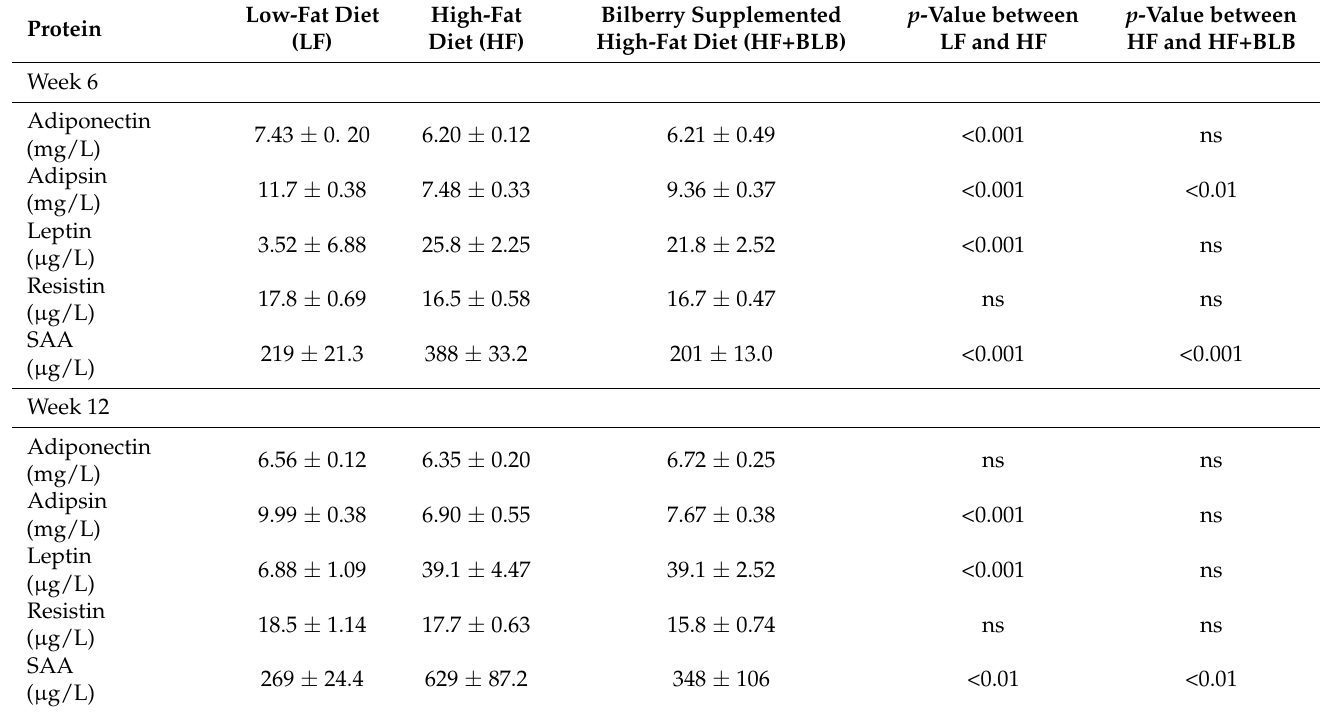
Table 2. The levels of circulating adipokines and serum amyloid A (SAA). The mice received a low-fat diet (LF, 10% energy from fat), a high-fat diet (HF, 46% of energy from fat) or a bilberry- supplemented high-fat diet (HF+BLB, 20% air-dried bilberry powder) for six or twelve weeks. The results are analyzed with a one-way ANOVA and a Bonferroni multiple comparisons test and expressed as mg/L for adiponectin and adipsin and µ g/L for leptin, resistin, and SAA. Values represent mean ± SEM; n = 12 mice in each group; ns = not significant ( p > 0.05).